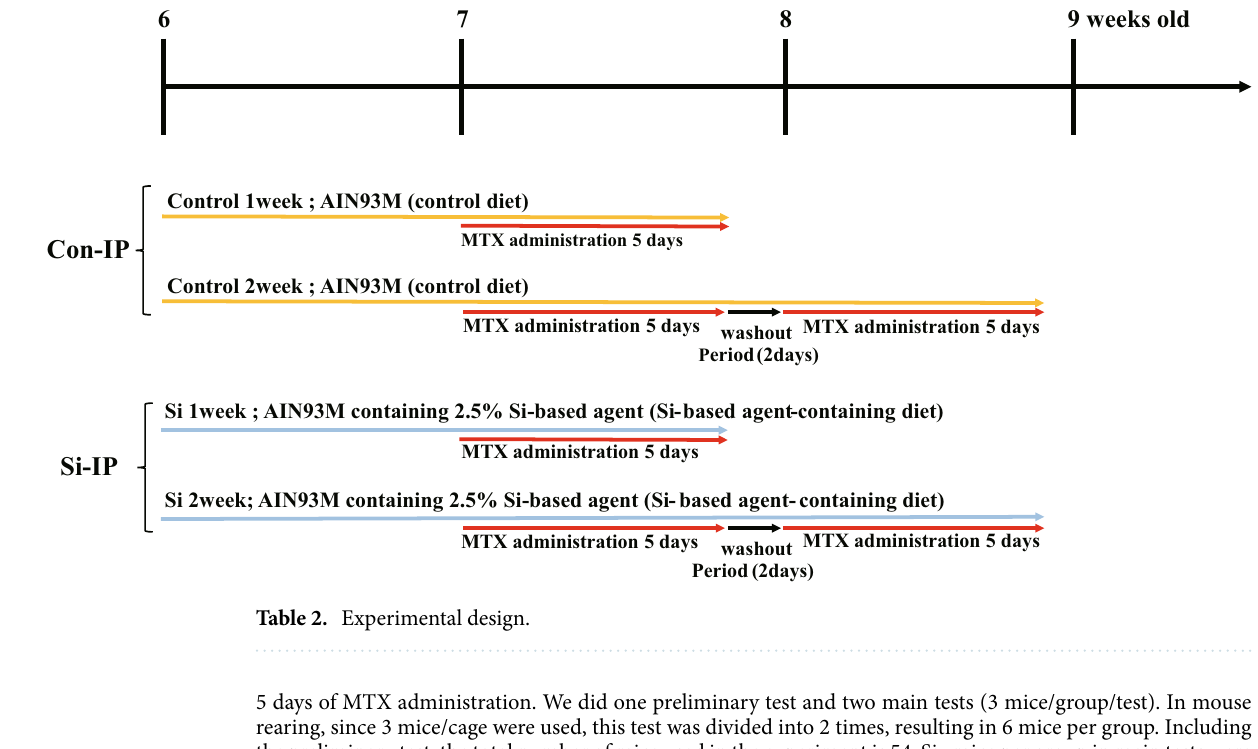
Table 2. Experimental